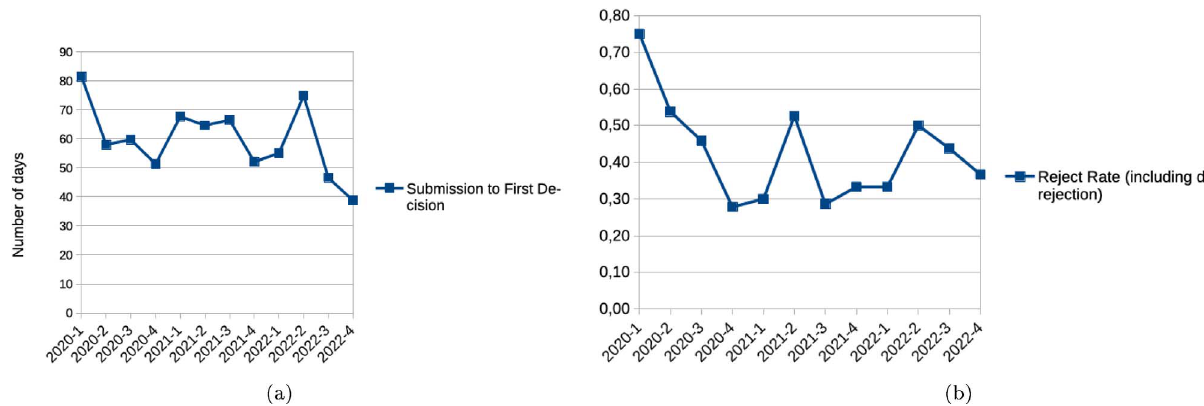
Figure 3. Submission to fi rst decision counted in days, and rejection rate. (a) Submission to fi rst decision. (b) Rejection of rate.